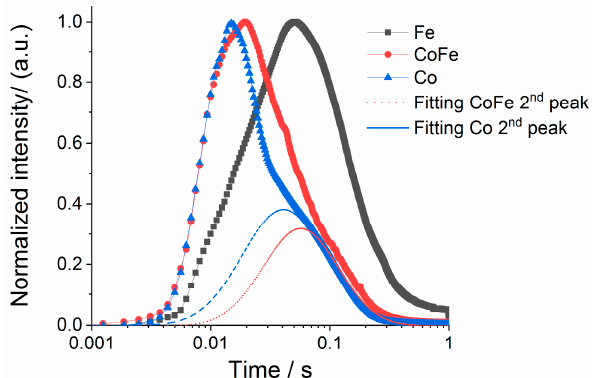
Figure 8. Height normalized hydrogen production rates collected for Fe, CoFe and Co during ammonia pulsing at 550 °C, deconvolution of secondary peak on CoFe and Co samples to emphasize timing of slower process.